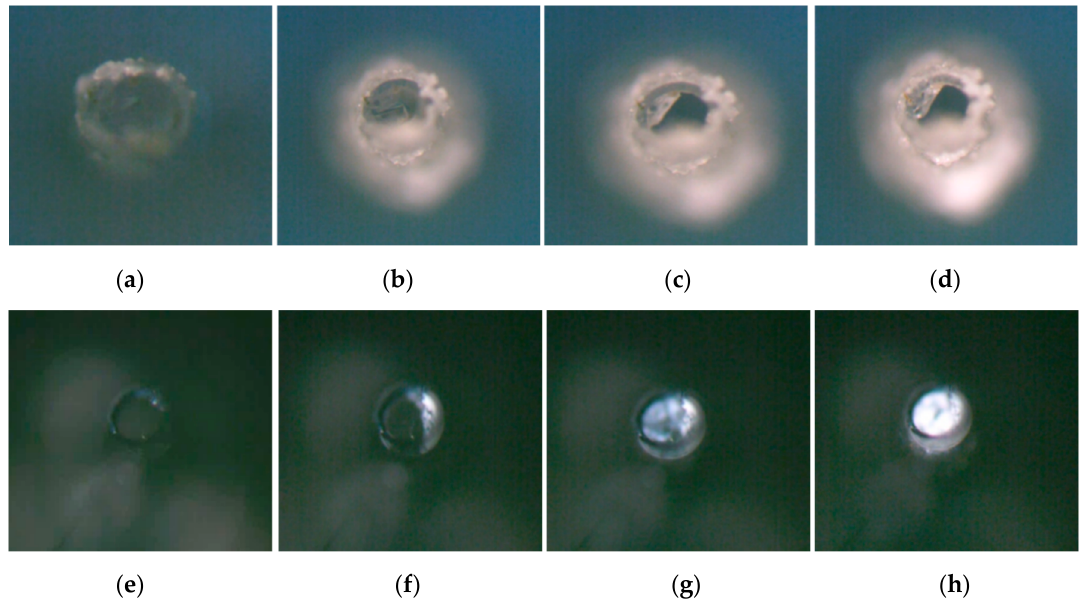
6 of 14 Figure 4. Time curve of salt droplets in different crystallization stages. 3.2. Migration Rate and Crystal Morphology of Salt Solutions in Capillary Tubes Figure 5a–d shows the crystallization change process of the NaCl solution, and Figure 5e,h shows the crystallization process of the Na 2 SO 4 solution at the mouth and the wall of the capillary tube with a diameter of 10.0 μ m. Considering that the capillary force, the gravity of the solution, the viscosity resistance, and the atmospheric pressure were the main forces in the capillary tube, when the capillary force of the solution in the tube was greater than the sum of the other pressures, the salt solution migrated to the opening tube and started to crystallize (heterogeneous nucleation), and the formed crystal nucleus